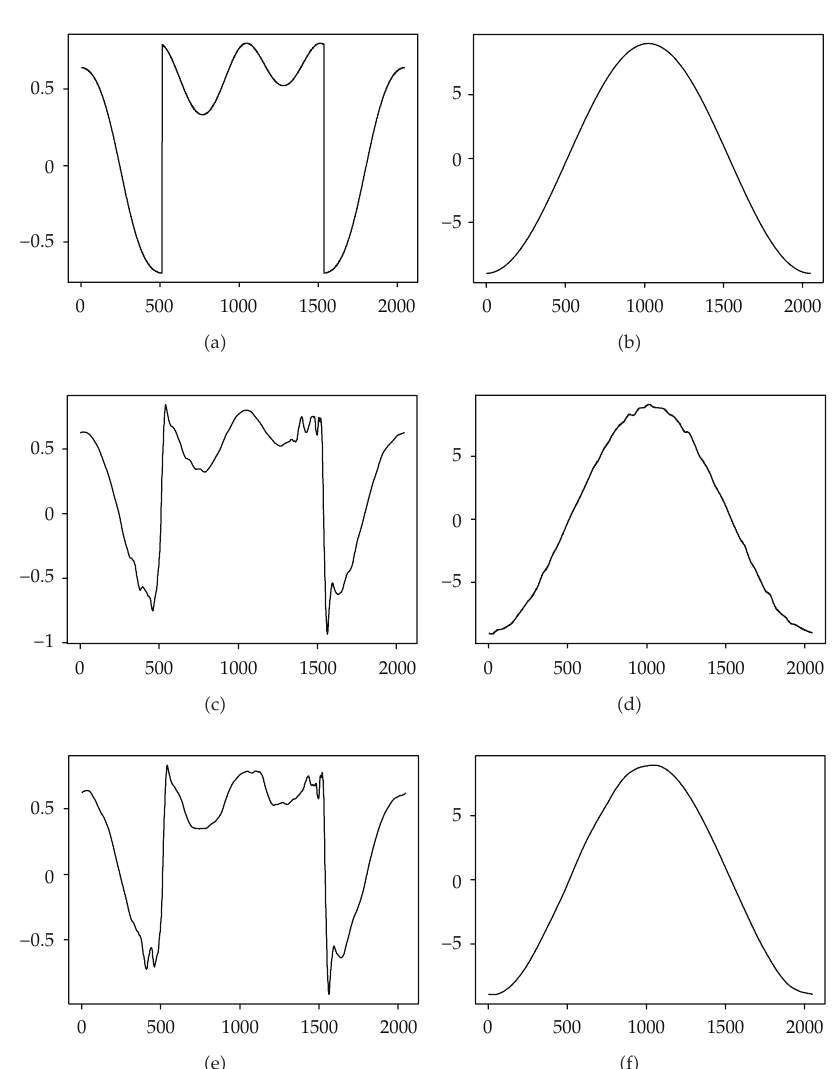
Figure 6: Example 5.2: True parameters and estimates using the Daubechies D8 wavelet: (cid:5) a (cid:6) δ 1 , (cid:5) b (cid:6) ω 0 , (cid:5) c (cid:6) (cid:7) δ (cid:5) d (cid:6) (cid:7) ω (cid:5) e (cid:6) (cid:5) δ (cid:5) f (cid:6) (cid:5) ω 1 , 0 , 1 , 0